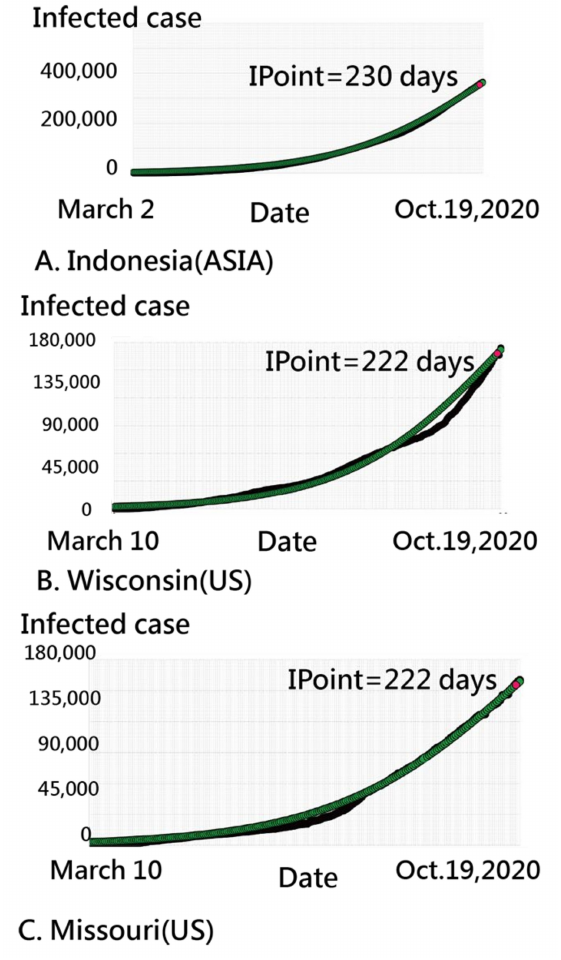
Figure 7. Comparison of epidemic trends displayed as ogive